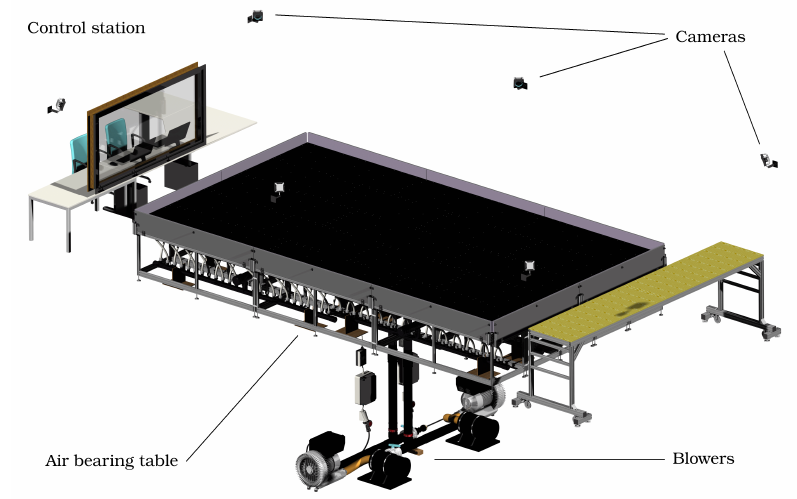
Figure 4. ELISSA testbed with control station, air-bearing table, cameras, and blowers.